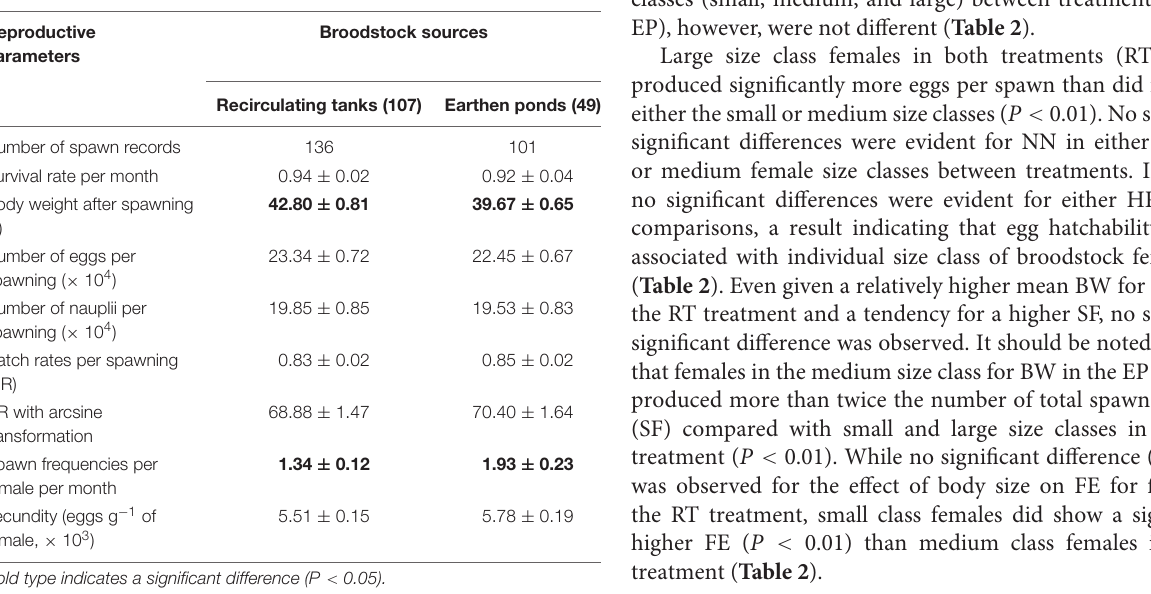
TABLE 1 | Comparison of reproductive performance ( ± 1 SE) of L. vannamei broodstock reared in two different treatments: earthen ponds (EP) vs recirculating tanks